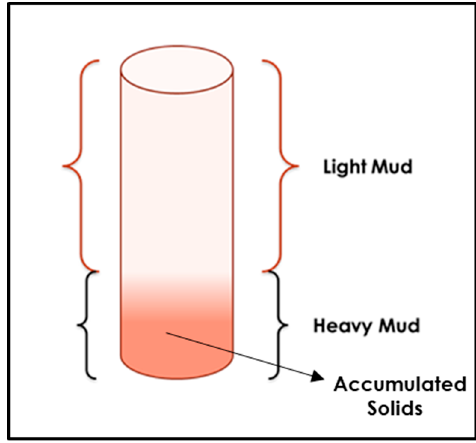
Figure 1. Solids sag phenomenon.